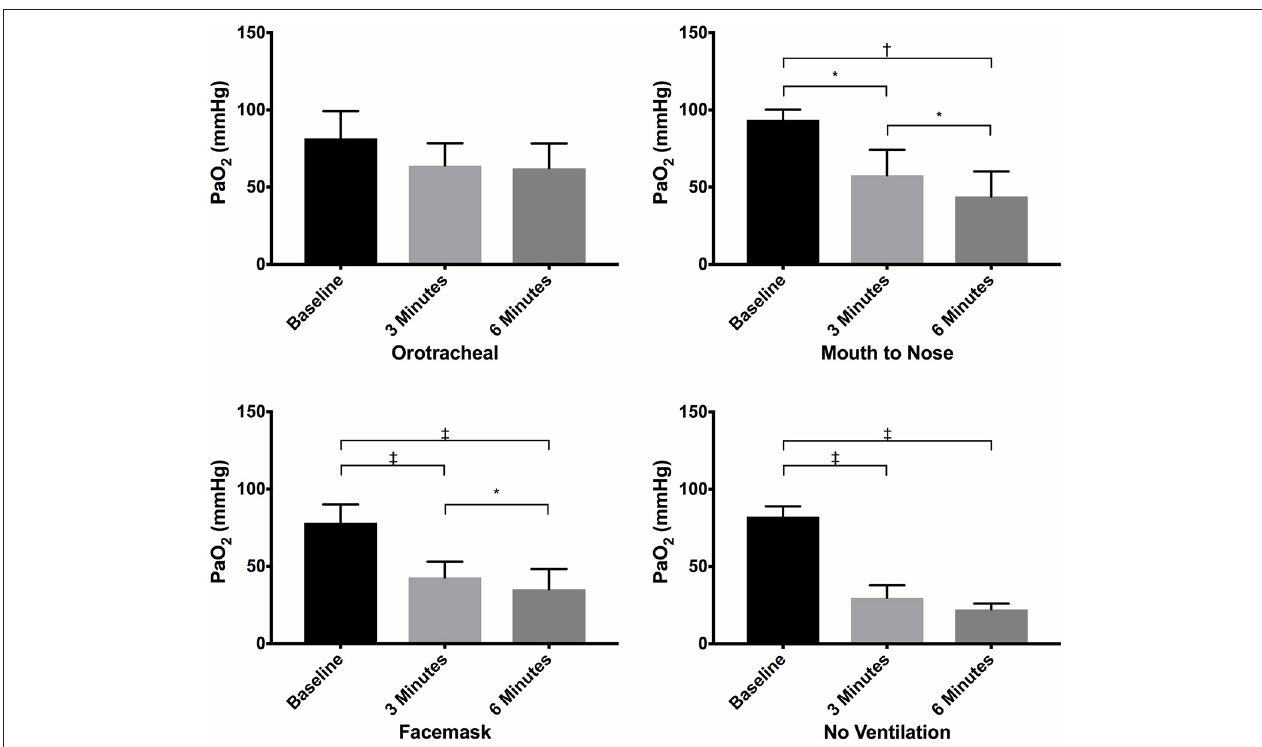
FIGURE 2 | Mean PaO 2 of dogs at baseline and at 3 and 6min of cardiopulmonary resuscitation for each ventilation technique. Bars represent standard deviation. * P < 0.05, † P < 0.005, ‡ P < 0.0005. Orotracheal, ventilation with bag resuscitator and cuffed orotracheal tube; Mouth-to-nose, rescue breaths with mouth over the nose; face mask, ventilation with bag resuscitator and a tight fitting face mask; No ventilation, compression only CPR.